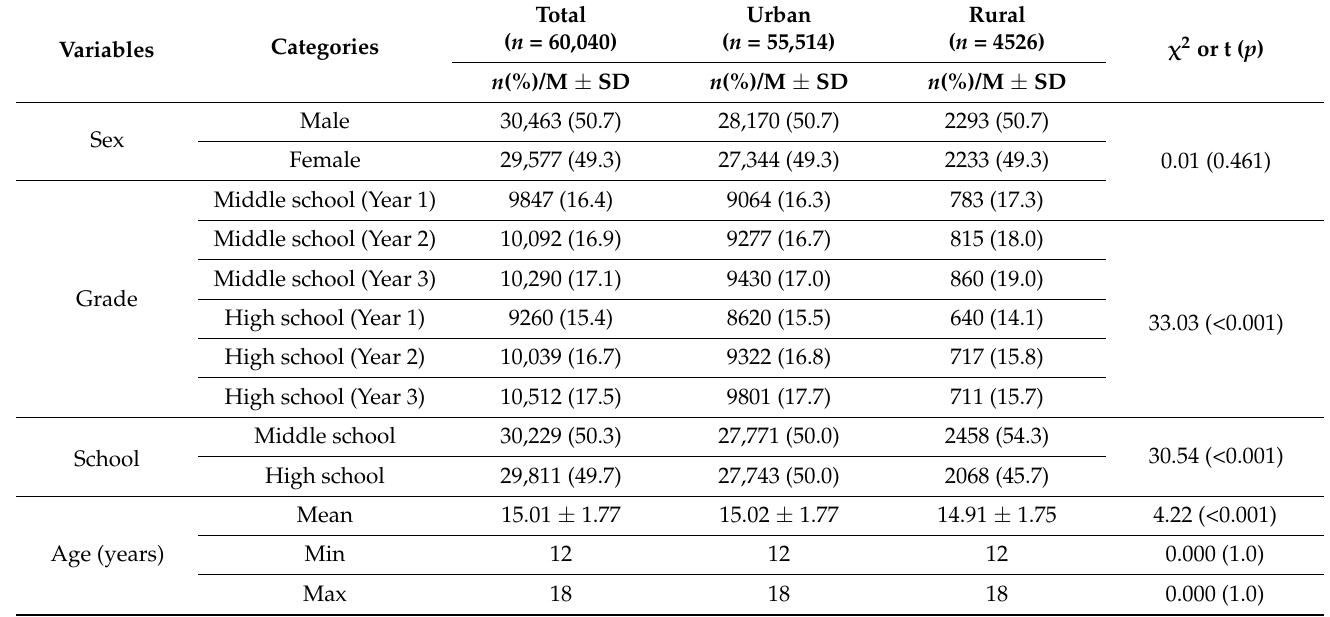
Table 1. Participant demographic